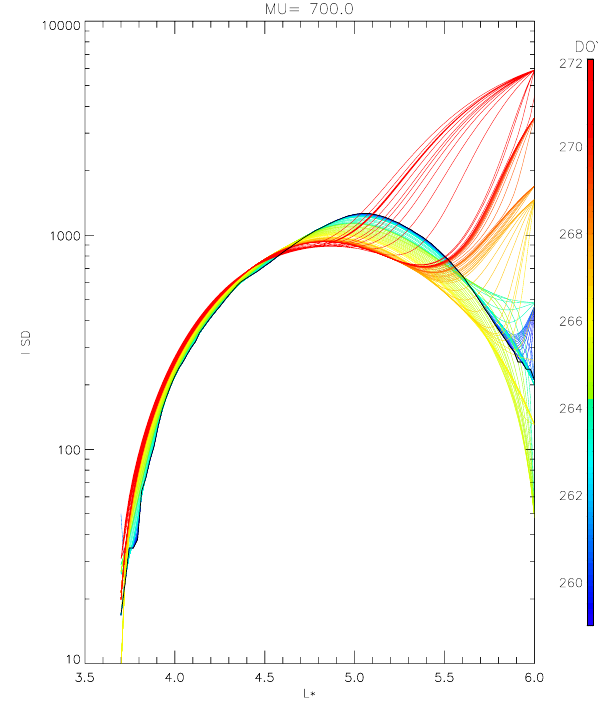
Figure 11. Time development of phase space density from a simu- lation using the MHD-based radial coefficient described in the text.